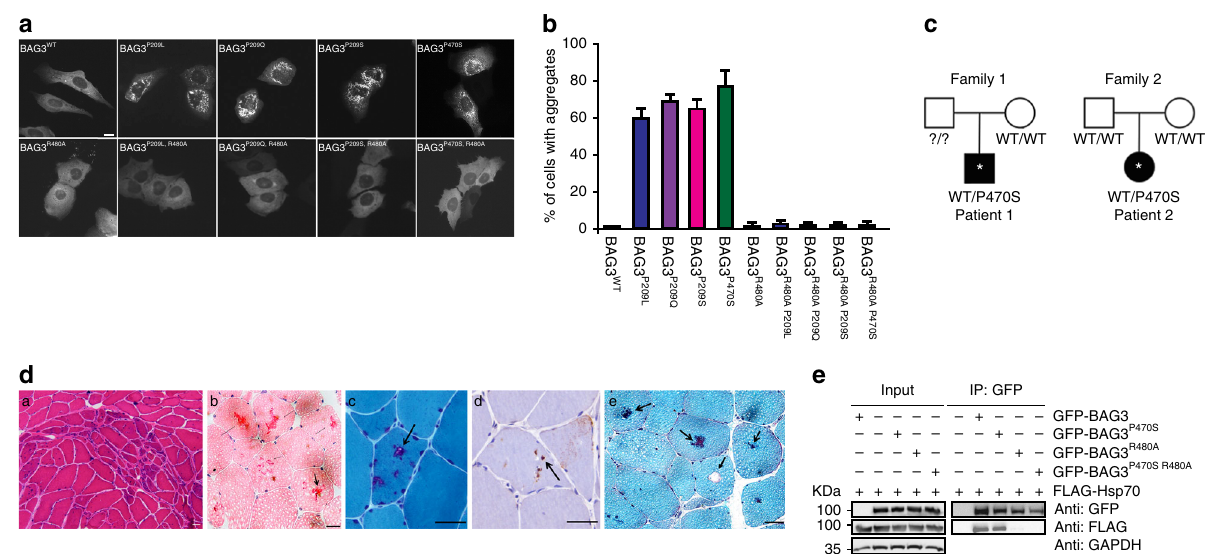
Fig. 8 MFM-causing BAG-domain mutations also cause HSP70-dependent aggregation. a Immuno fl uorescence pictures of HeLa cells expressing the indicated BAG3-disease causing mutants, with or without the additional R480A mutation that abrogates the ability of the (mutant) BAG3s to interact with Hsp70. Scale bar = 5 μ m. b Analyses of the number of cells expressing the indicated BAG3-disease causing mutants (with or without the additional R480A mutation that abrogates their ability BAG3s to interact with Hsp70) that contain over 20 punctae. The increase in cells with punctae in the single mutant backgrounds and their abrogation in the double mutant backgrounds are signi fi cant with a P value of <0.00005 ( t test). c Pedigree structures and known genotype of the proband (*) and parents in Family 1 and Family 2 with a P470S mutation in the BAG-domain. d Histochemical and immunohistochemical analysis of muscle biopsies from two novel MFM patients carrying a P470S mutation in the BAG domain of BAG3: Patient 1 ( a – c ) and Patient 2 ( d , e ) (see Fig. S6B, C for further patient info); a hematoxylin and eosin (H&E) staining demonstrates region of grouped atrophy with small fi bers harboring vacuoles; b modi fi ed gomori trichrome (GT) staining demonstrating both cytoplasmic inclusion and rimmed vacuoles; c immunohistochemistry with an antibody to TDP-43 demonstrates protein accumulation; d H&E staining shows large centrally located eosinophilic inclusion; e GT staining shows dark centrally located inclusions and a fi ber with a centrally located vacuole. Arrows denote protein inclusions or vacuoles. Scale bar = 50 μ m. e Immunoprecipitation of GFP- tagged BAG3 variants from cells expressing both GFP-BAG3 variants and FLAG-tagged HSP70. Western blots using the indicated antibodies is shown. Source data are provided as a Source data fi le